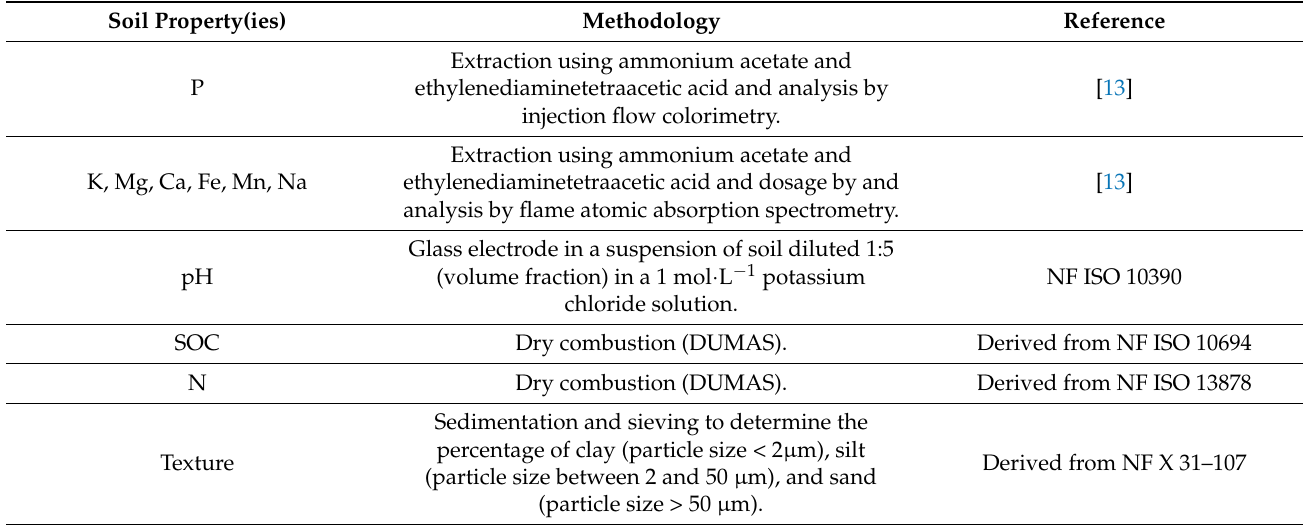
Table 1. Soil properties monitored and methodology used for the samples